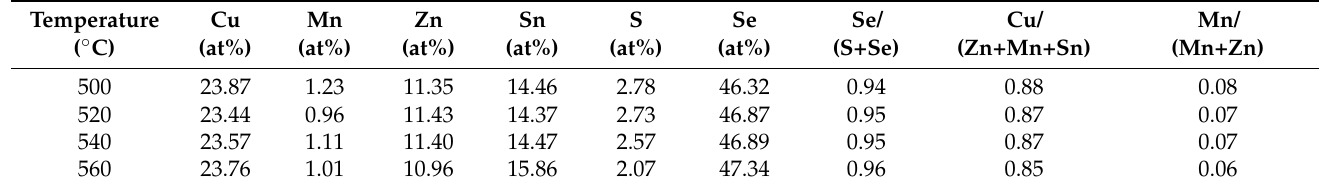
Figure 7. SEM surface images of the CMZTSSe films annealed at 500 ◦ C ( a ), 520 ◦ C ( b ), 540 ◦ C ( c ), and 560 ◦ C ( d ); EDS mapping images for Cu, Zn, Mn, Sn, S, and Se elements in the CMZTSSe film annealed at 540 ◦ C ( e – j ). Table 1. EDS results of the CMZTSSe films annealed at different temperatures from 520 to 560 ◦